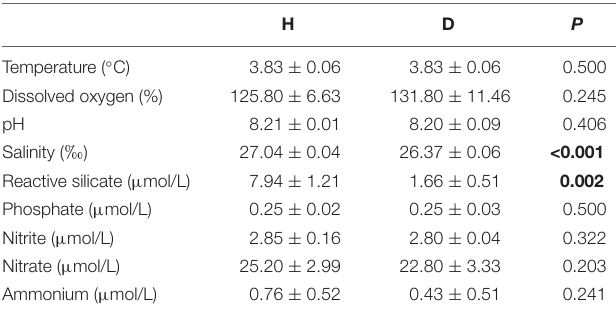
TABLE 1 | Summary of the seawater sample physico-chemical parameters for the H and D